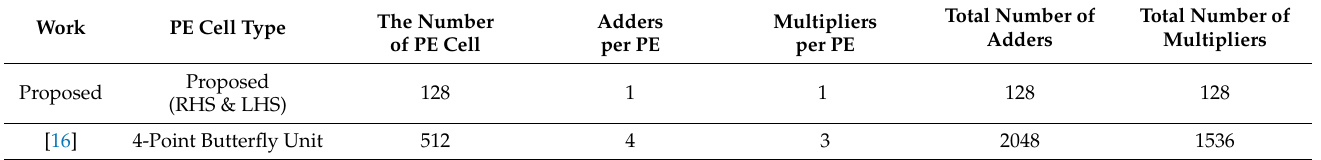
Table 4. Comparison of PE unit with